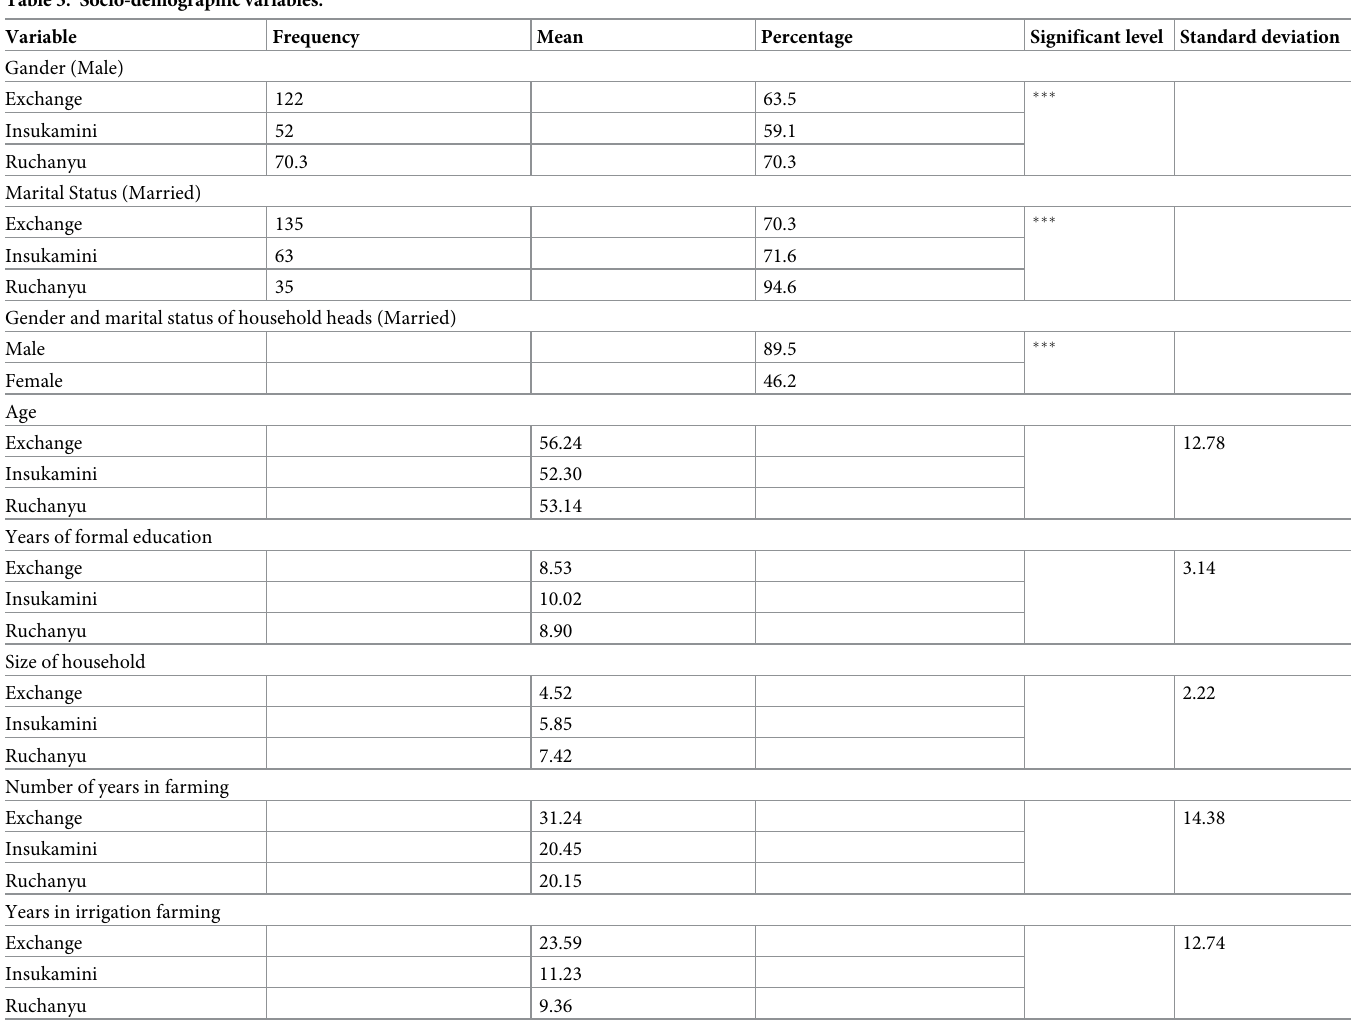
Table 3. Socio-demographic